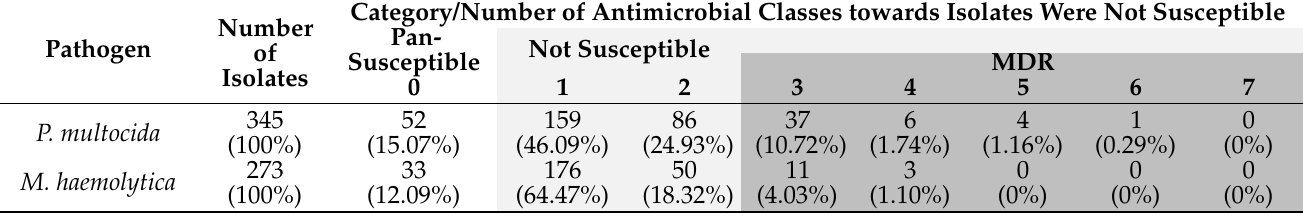
Table 4. Amongst the investigated bacterial species, the absolute and (relative) number of isolates was ranked into the characteristic pan-susceptible, if these were susceptible towards all agents tested. Not susceptible isolates revealed to be resistant against at least two tested antimicrobial classes (shaded in light grey), and multidrug-resistant (MDR) isolates revealed to be resistant against three or more tested antimicrobial classes (shaded in grey).